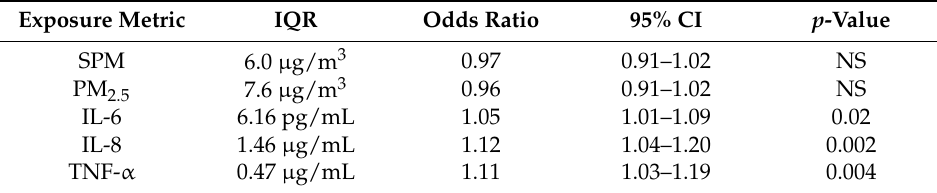
Table 2. Multivariate analysis using generalized estimating equation (GEE) logistic regression models to assess the association between respiratory symptoms and interquartile range (IQR) changes in the levels of suspended particulate matter (SPM), particulate matter <2.5 µ m in diameter (PM 2.5 ), interleukin (IL)-6, IL-8, and tumor necrosis factor (TNF)- α . Exposure Metric IQR Odds Ratio 95% CI p -Value SPM 6.0 µ g/m 3